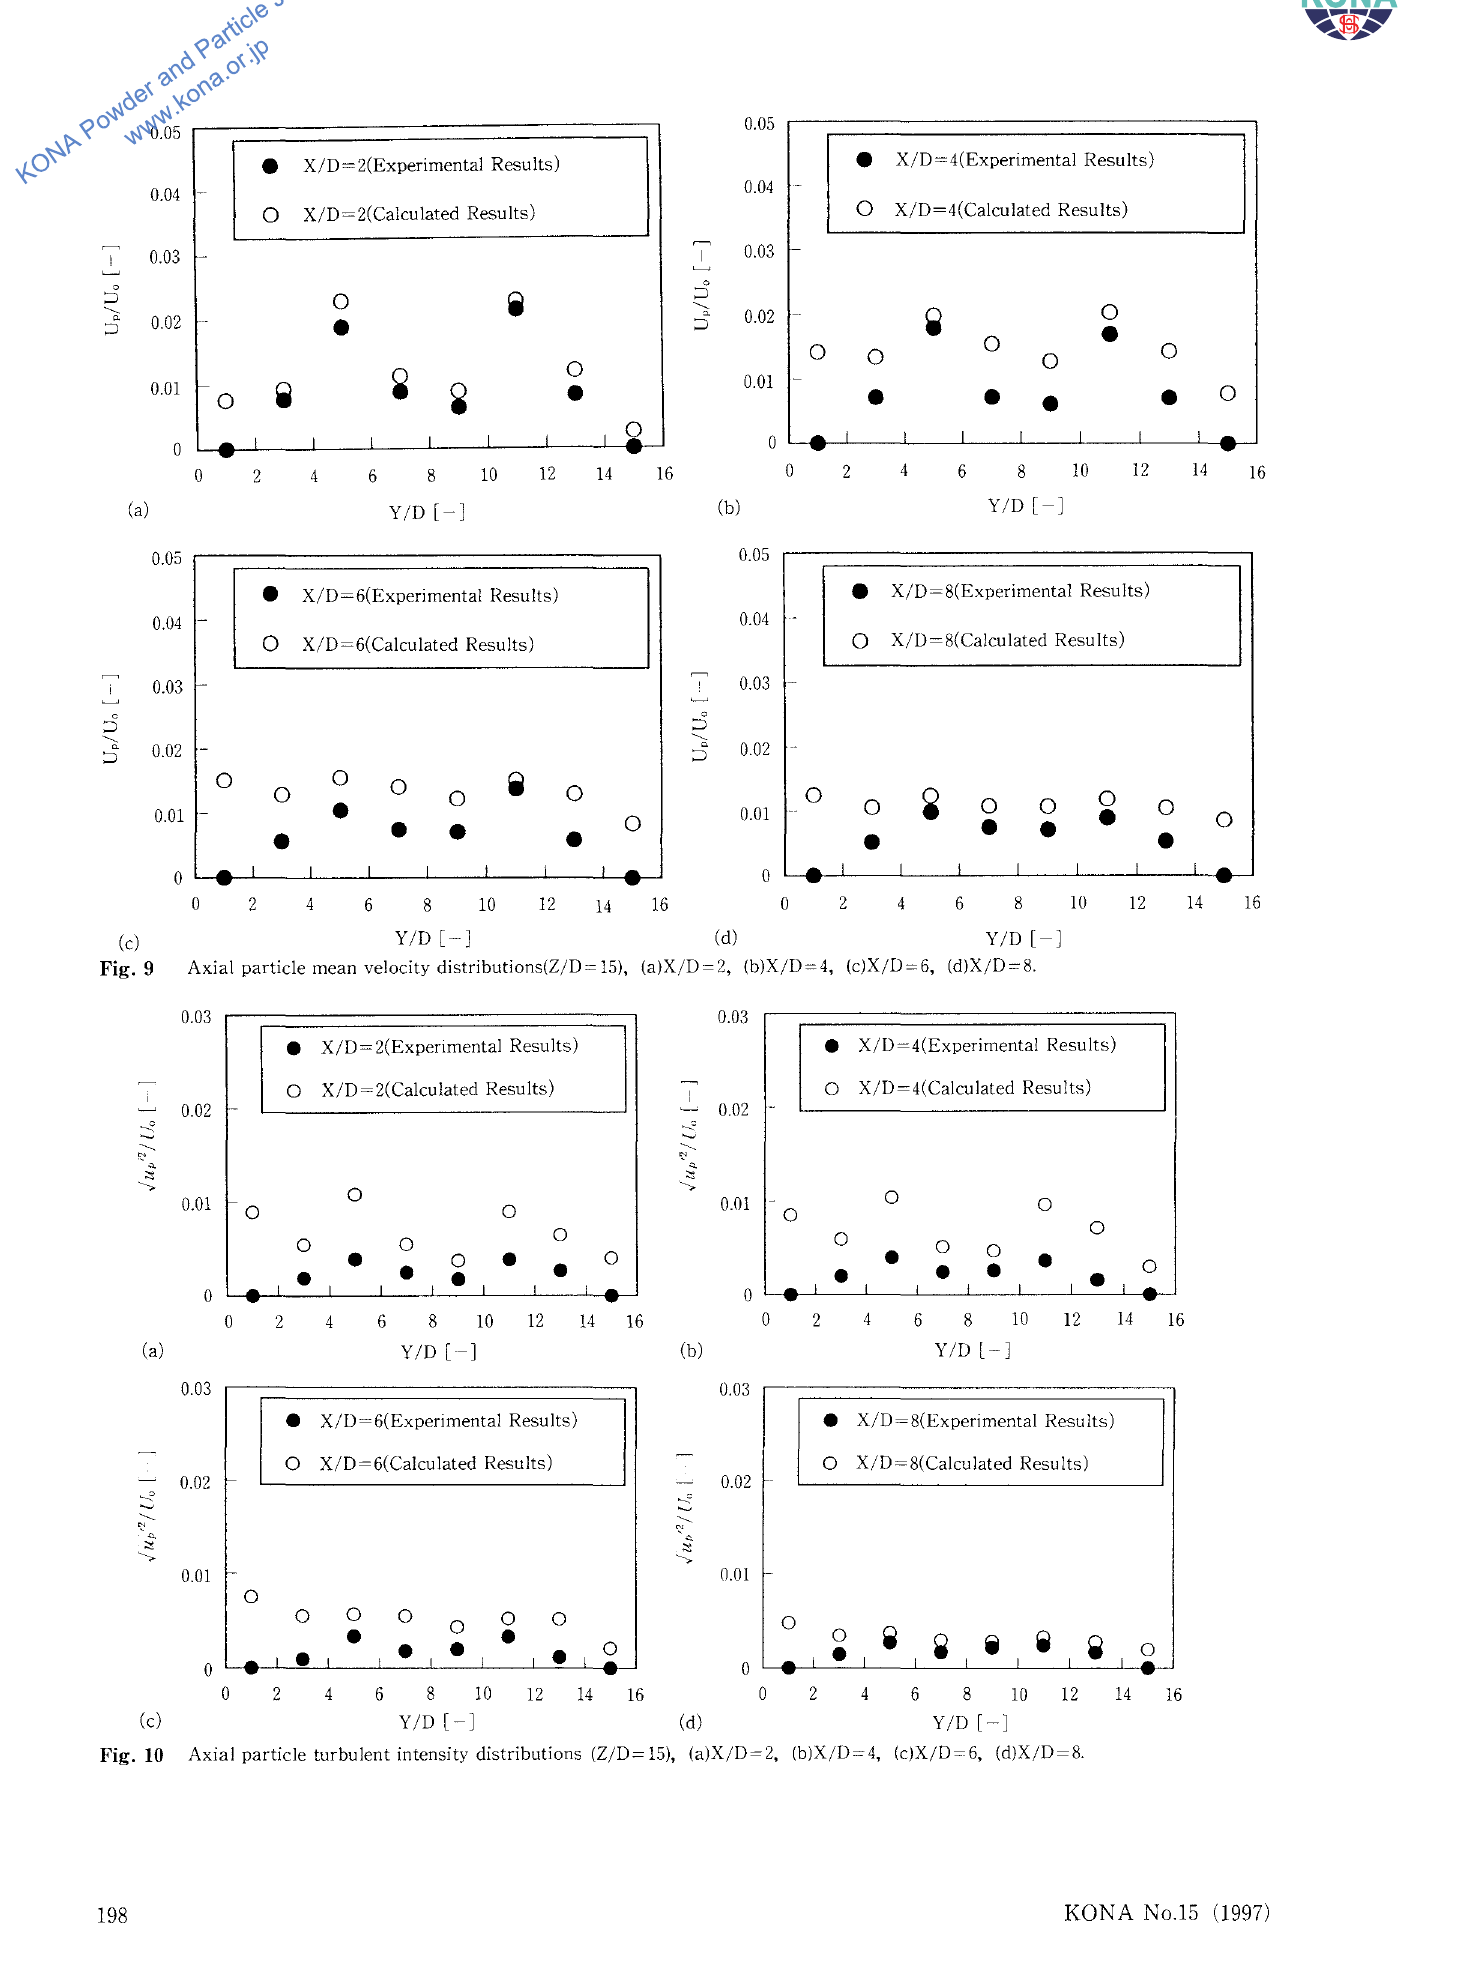
Fig. 10 Axial particle turbulent intensity distributions (Z/0= 15), (a)X/0=2, (b)X/0=4, (c)X/0=6,